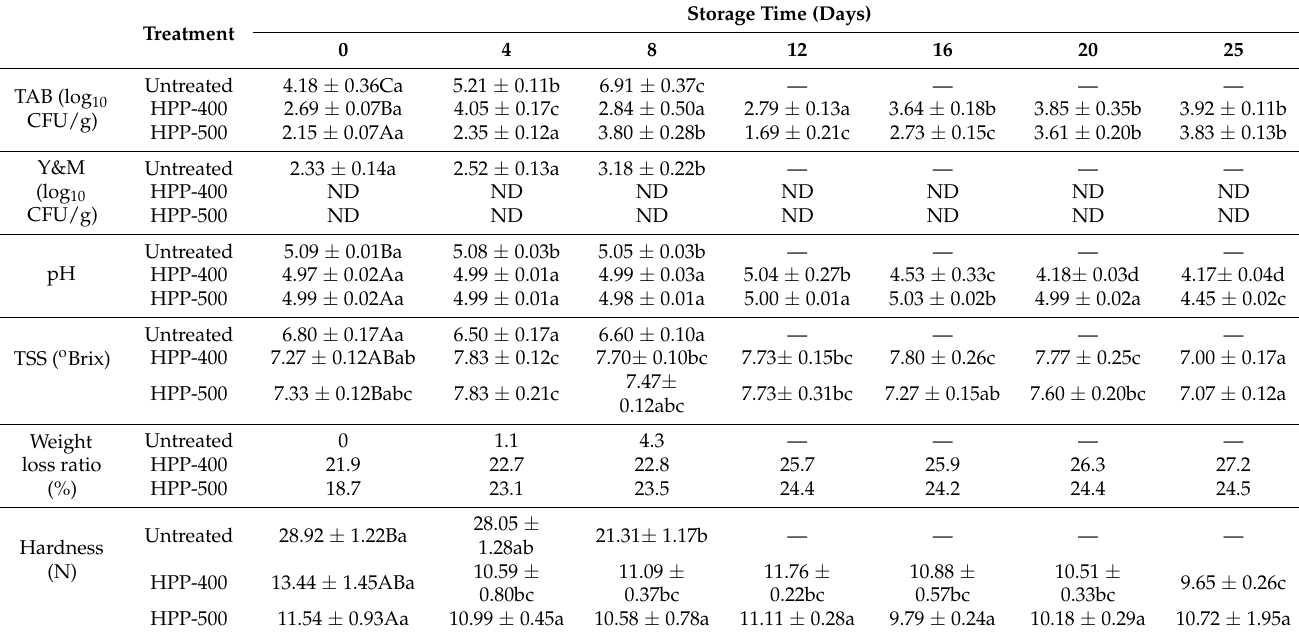
Table 3. Changes in microorganisms, pH, total soluble solids (TSSs), weight loss ratio, and hardness of fresh-cut bell peppers during storage at 4 ◦